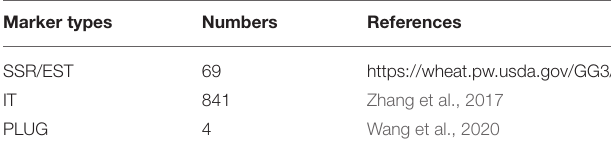
TABLE 1 | Markers used in this